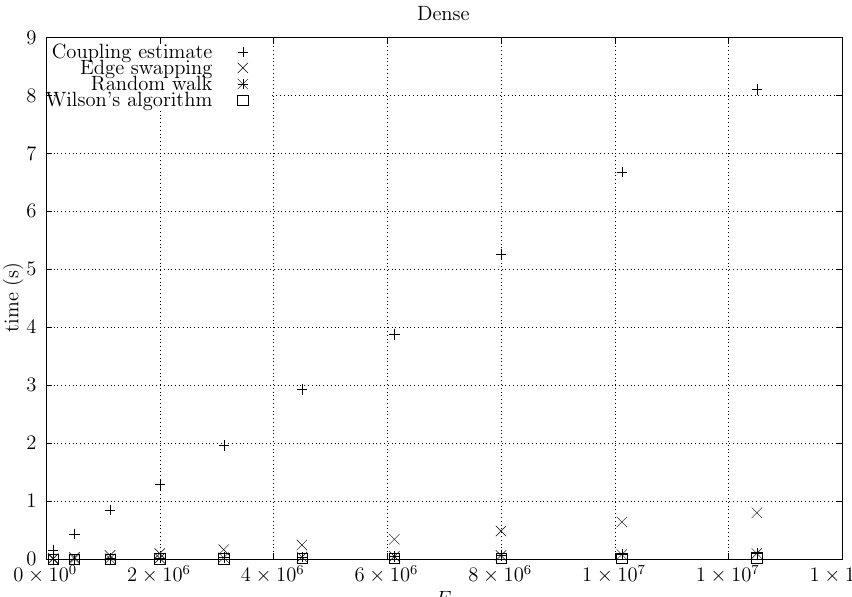
Figure 26. Running times for dense (fully connected) graphs averaged over five runs, including the running time for computing the optimistic coupling estimate and the running time for generating a spanning tree based on that estimate, as well as the edge-swapping algorithm, the running time for generating a spanning tree through a random walk, and the running time for Wilson’s algorithm.